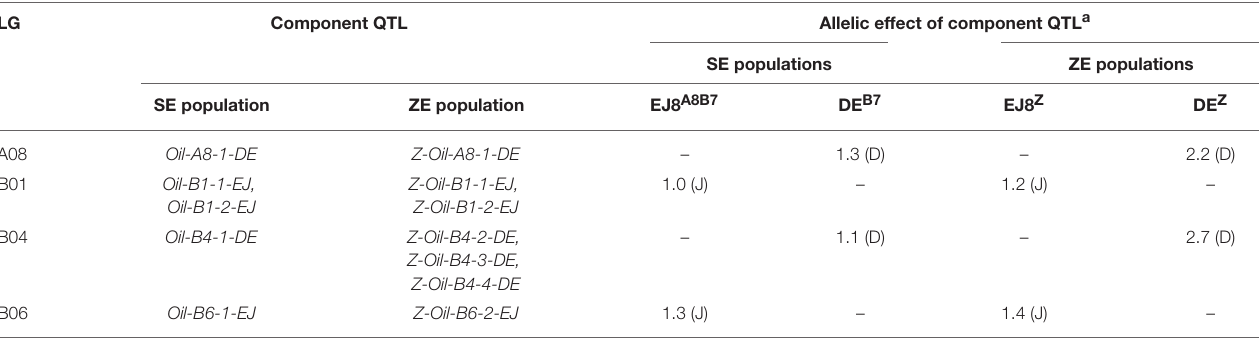
TABLE 7 | Comparison of allelic effects (%) of Oil QTL underlying the “common” QTL between SE and ZE background in the mapping populations resourced from the same parental crosses. LG